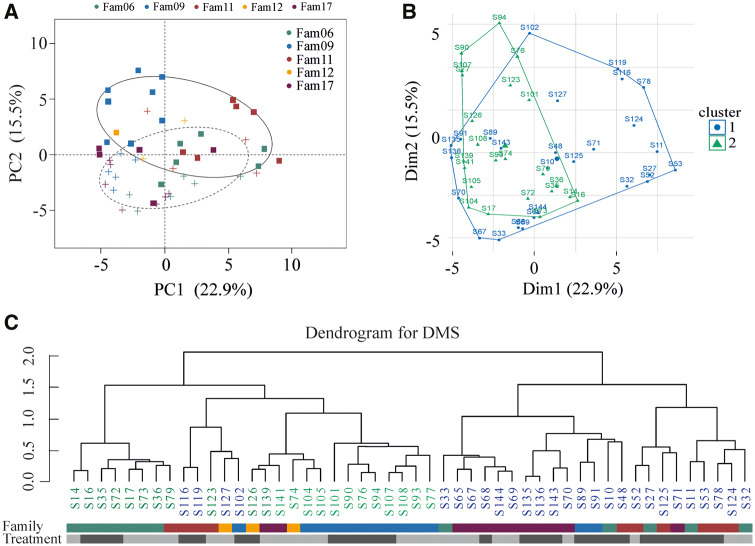
Cluster analyses for DMSs between treatments. (A) PCA for the differentially methylated sited between infected and control fish brothers. Principal component 2 axis (15.5%) separates fish based on their treatment. Squares denote fish exposed to parasites and crosses denote the control ones. Families are highlighted with different colors. Ellipses represent the 95% confident intervals. (B) k-Mean statistics for DMSs suggested the presence of two groups that match the infection treatments (Shimodaira–Hasegawa test). (C) Hierarchical clustering. k-Mean indicated the presence of two major clades that fit better with treatment specific rather than family. Treatment bar: open gray refers to control and dark gray to infected.